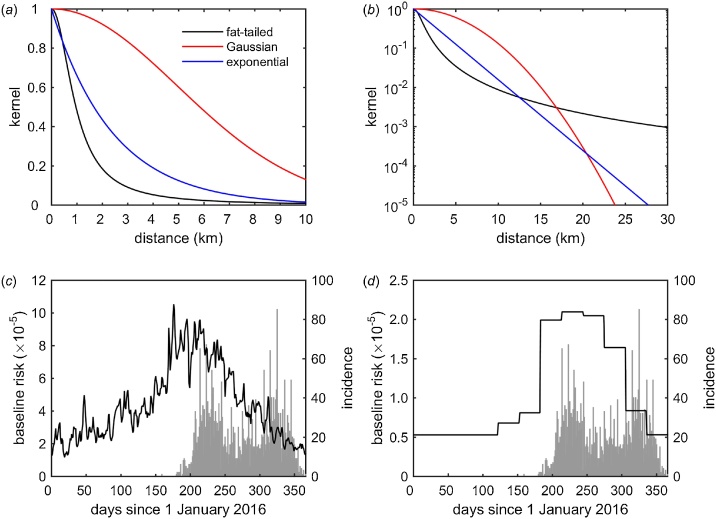
Transmission of lumpy skin disease virus (LSDV) in Albania in 2016. (a,b) Transmission kernels for LSDV plotted on a (a) linear or (b) logarithmic scale. (c,d) Seasonal transmission rate of LSDV when it depends on (c) daily mean temperature or (d) simulated relative abundance of Stomoxys calcitrans, a putative vector of LSDV. The plots show the transmission rate, h(t) (black line, left-hand axis), and the daily incidence of newly reported herds (grey bars, right axis). The fat-tailed kernel and the transmission rate dependent on relative vector abundance yielded the best fits to the outbreak data. (For interpretation of the references to colour in this figure legend, the reader is referred to the web version of this article).